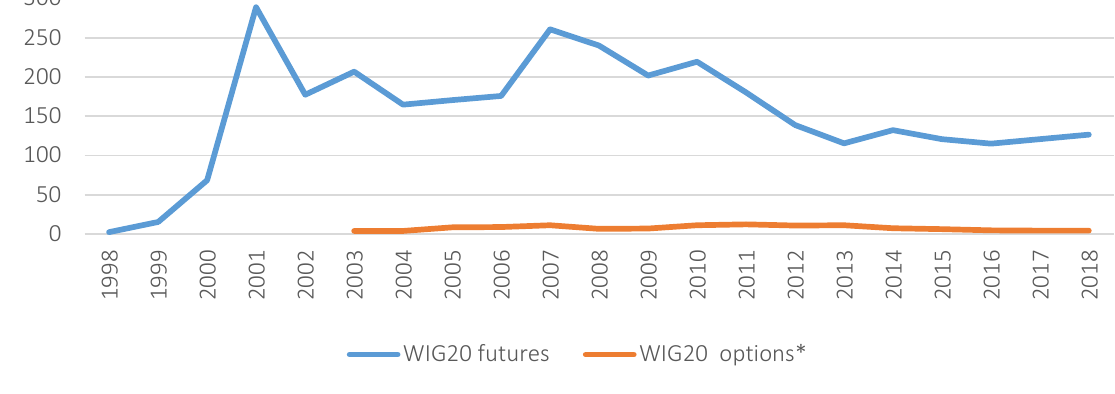
Figure 5. Liquidity ratio for derivatives (%) in